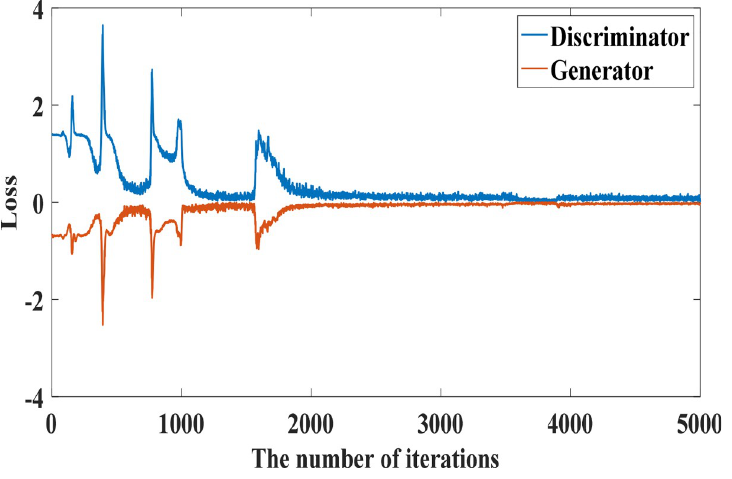
Fig 10. Change of GAN loss